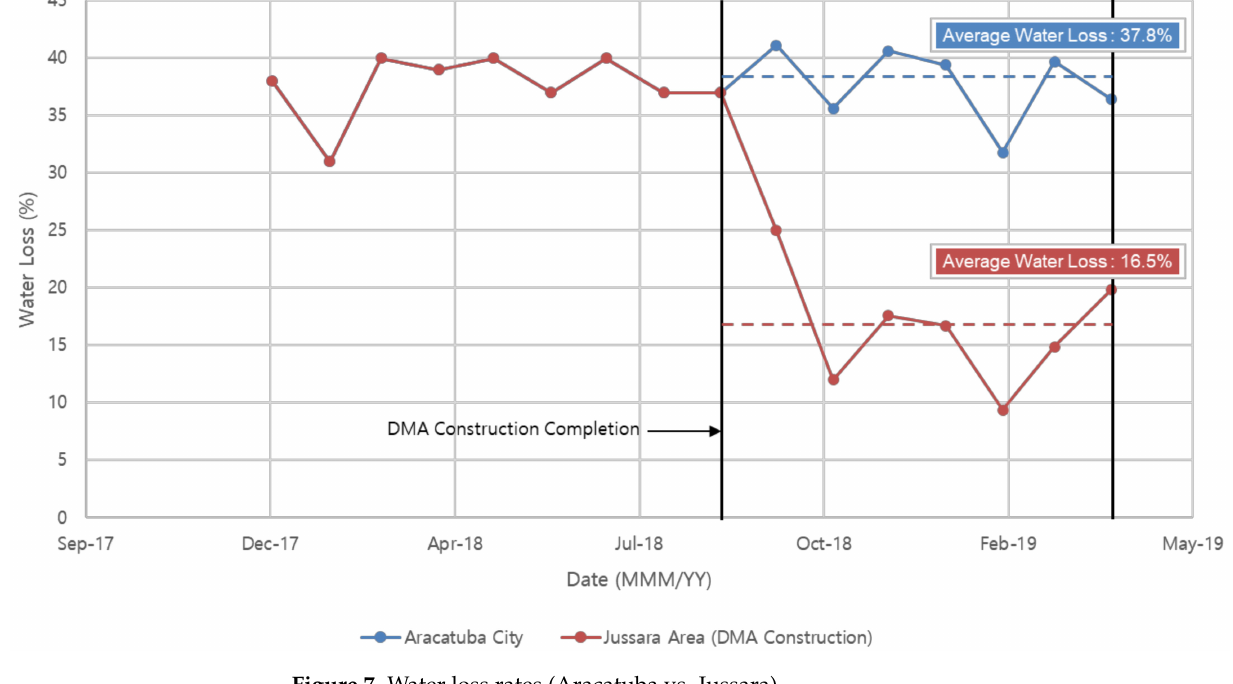
Figure 7. Water loss rates (Aracatuba vs. Jussara). Table 2. Non-revenue water ratios (Aracatuba vs.